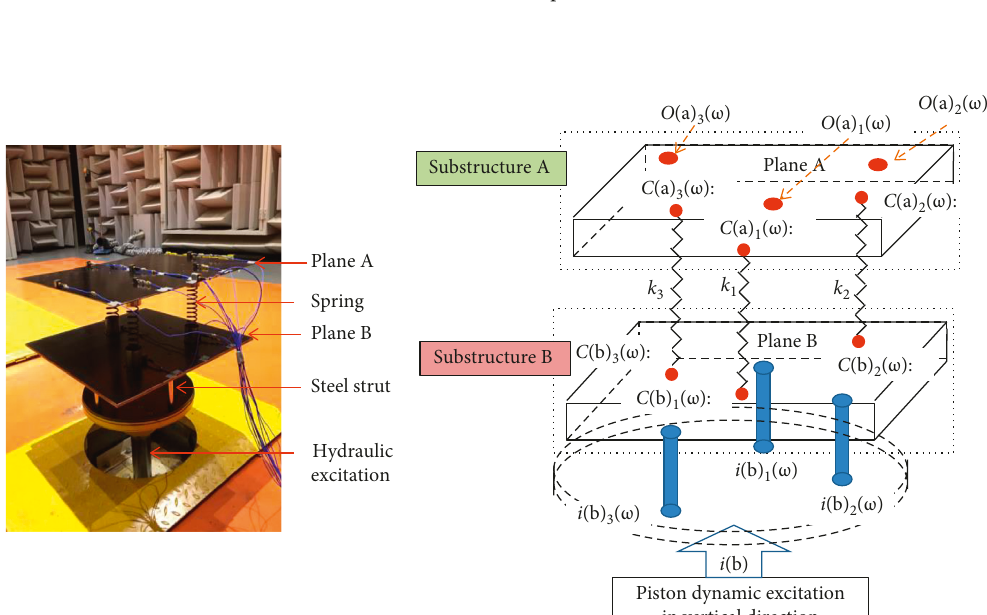
Figure 6: Picture of testing facility (a) and the location of points within this facility